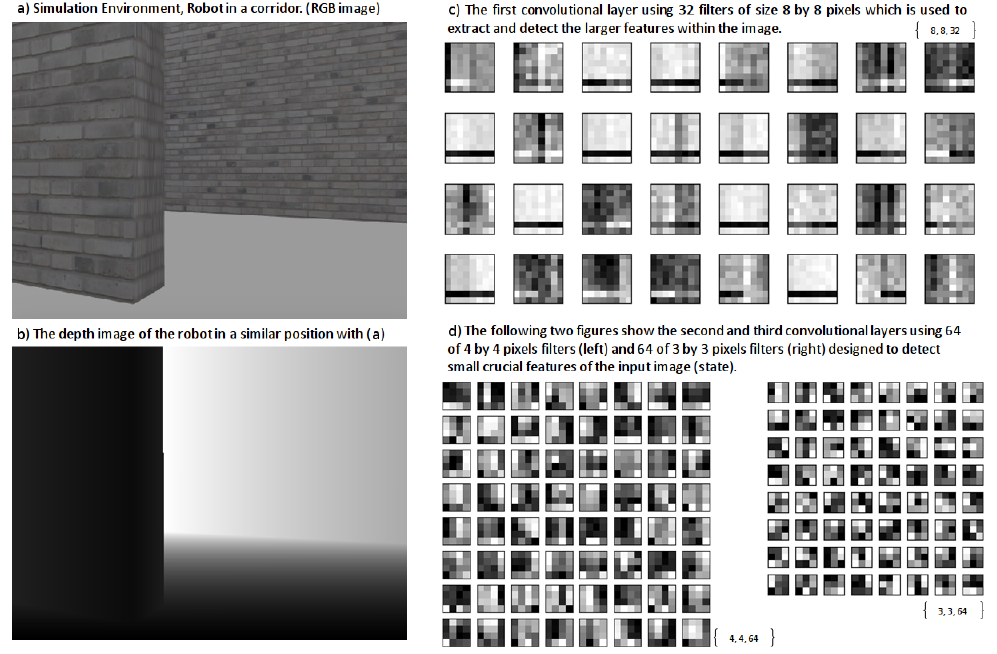
Figure 9. Visualization of our DNN (convolutional neural